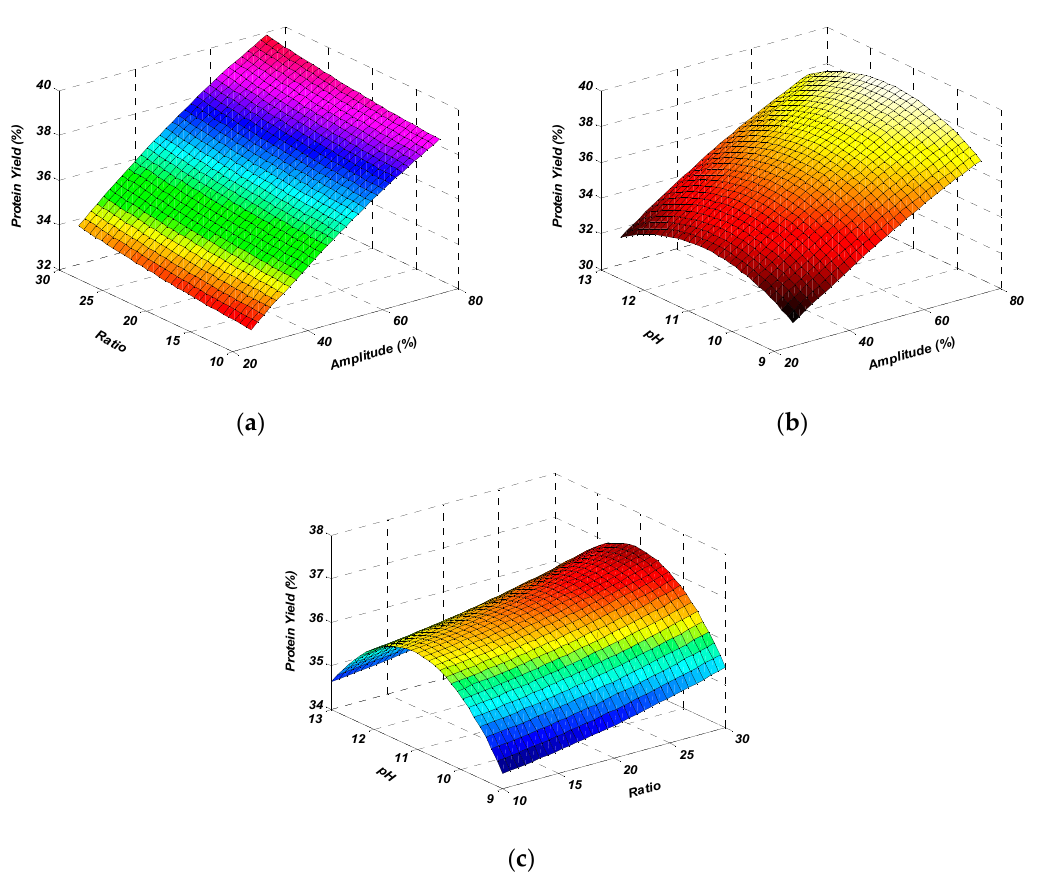
Figure 2. Response surface plots representing the effect of mutual interactions of studied parameters on the protein yield. Interaction between amplitude & ratio ( a ), amplitude & pH ( b ) and ratio & pH ( c ) while keeping third parameter at central value.